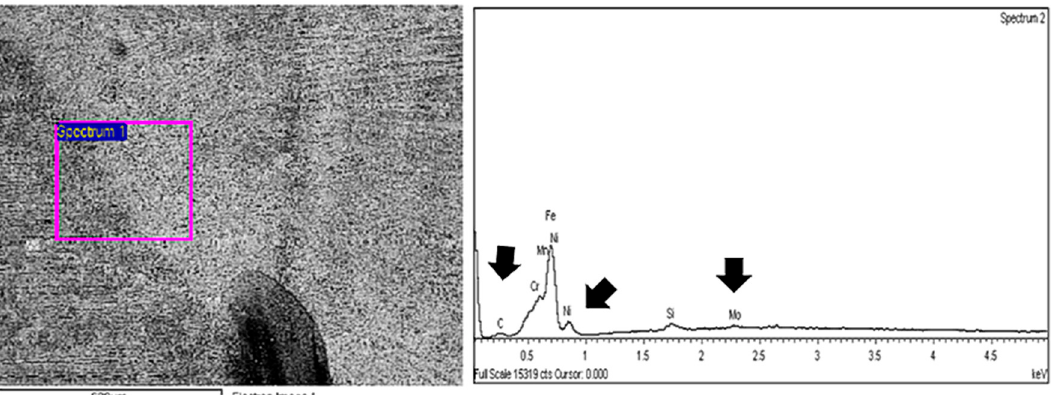
Figure 6. SEM spectrum and micrograph of the AISI 304 steel weld with AISI 316L filler welded in a conventional atmosphere and irradiated at 200